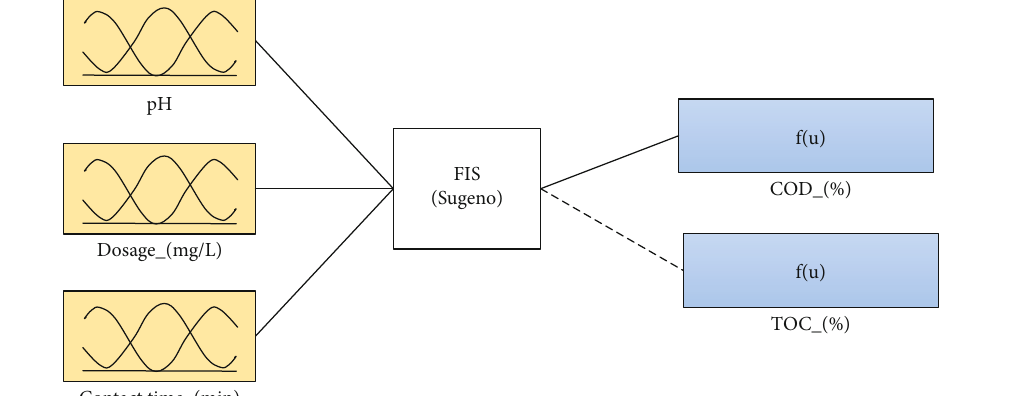
Figure 1: Schematic diagram of ANN model.